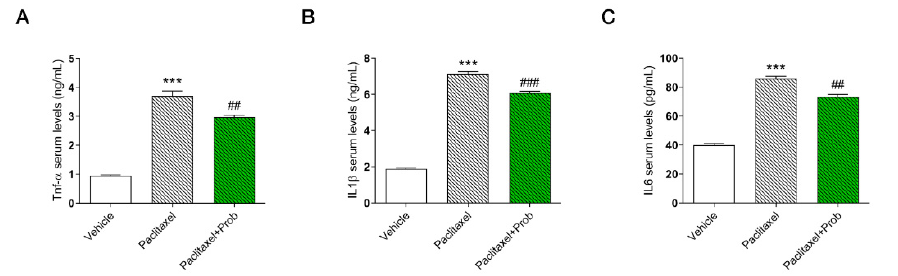
Figure 6. Pro-inflammatory Tnf- α ( A ) and IL1 β ( B ) and IL6 ( C ) concentrations in serum analyzed by ELISA. ***, p < 0.0001; vs. vehicle; ###, p < 0.0005; ##, p < 0.005 vs. paclitaxel ( n = 3).